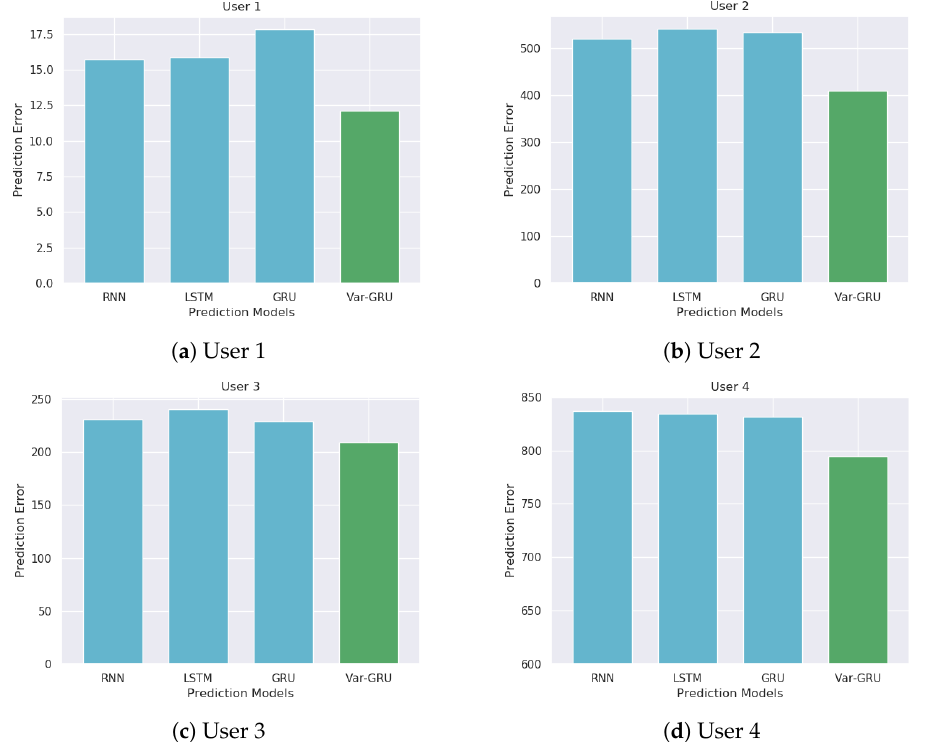
Figure 6. Impact of different mobility behaviours on the performance of the mobility